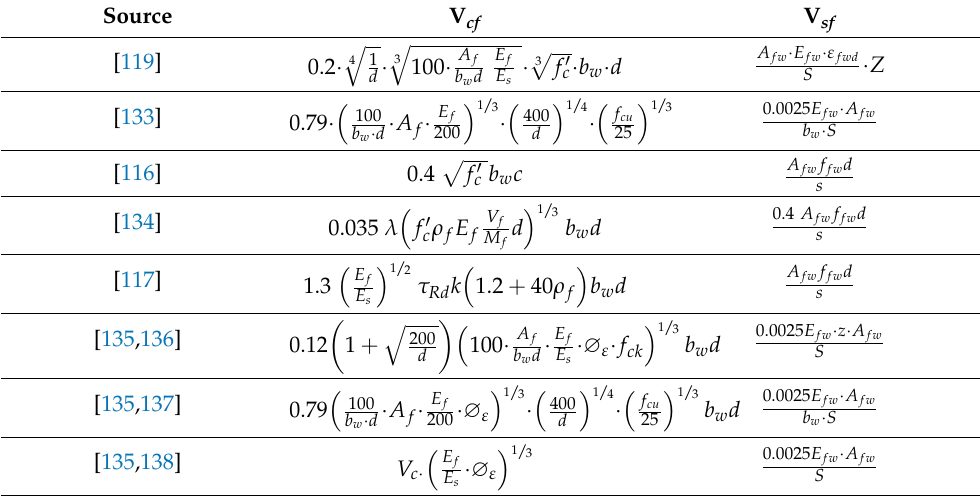
Table 3. Modifications to code design